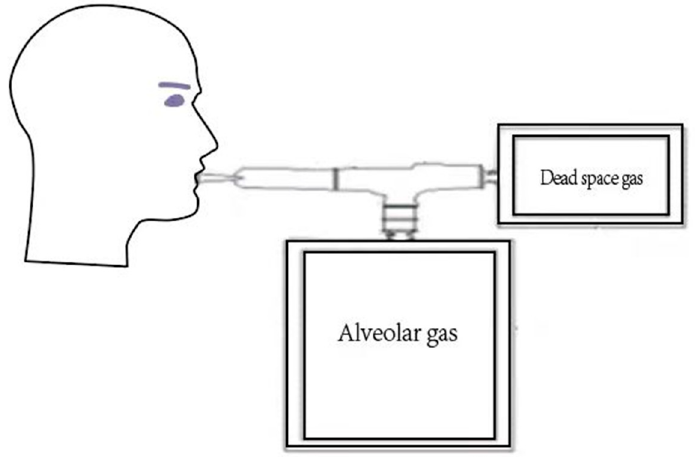
Figure 1. Alveolar gas collecting